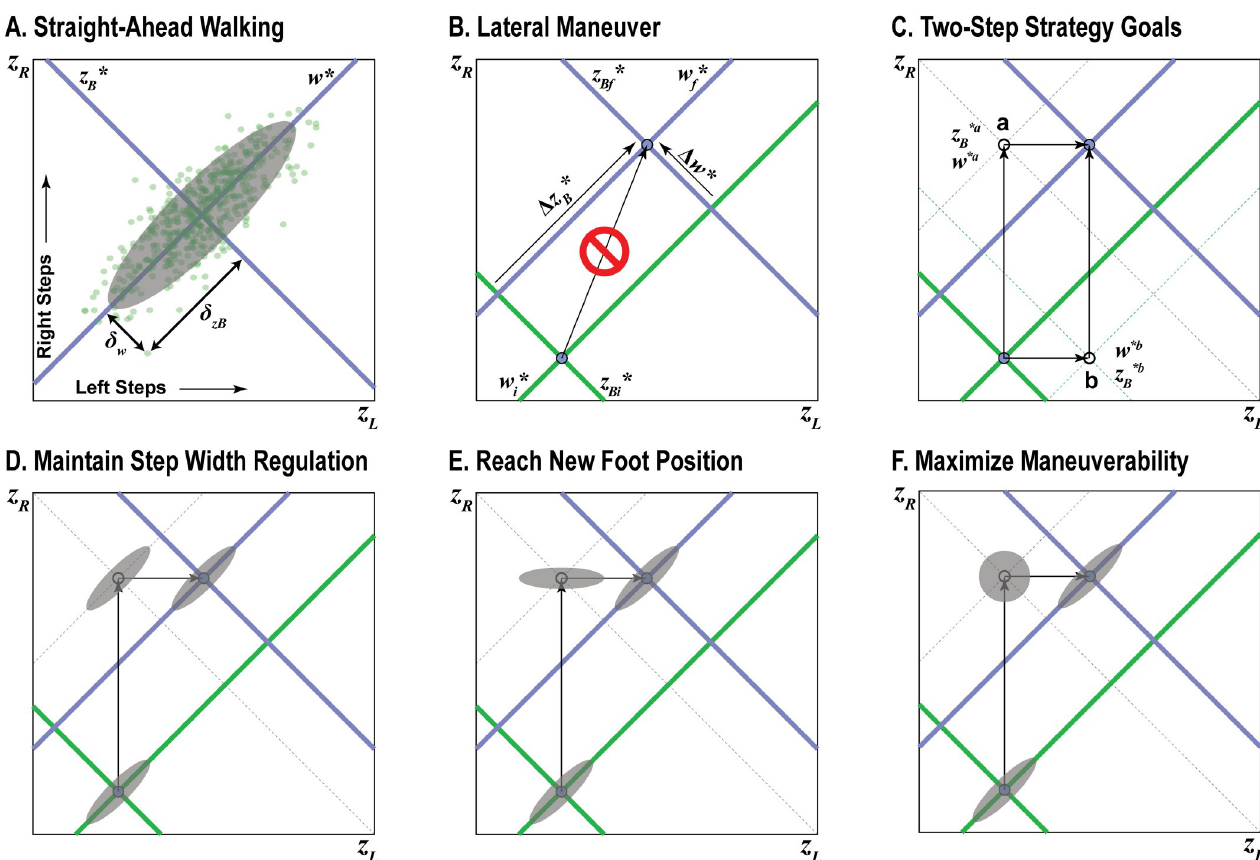
Fig 4. Conceptual Depiction of Task Performance. A) When viewed in the [ z L , z R ] plane, goals to maintain constant position ( z B � ) or step width ( w � ) each form linear Goal Equivalent Manifolds (GEMs) that are diagonal to the z � and w � GEMs characterize the stepping distribution at a given step and reflect the relative weighting of z both the z B walking, humans strongly prioritize regulating w over z B , producing stepping distributions strongly aligned to the w � GEM. B) Any maneuver would then involve a substantial change from some initial (green) to some new final (blue) stepping goals that will displace these GEMs diagonally in the [ z such as the theoretical rightward shift in z B � ( Δ z B � ) and increase in w � ( Δ w � ) depicted here. To accomplish such a maneuver requires changing both z L and z R . This cannot be achieved in any single step. C) At least two consecutive steps (either ‘a’: z maneuver ( Δ z B � and/or Δ w � ). Each possible intermediate step (‘a’ or ‘b’) has its own distinct stepping goals. D-F) For any given intermediate step, numerous feasible strategies to execute the maneuver are theoretically possible. D) One such strategy might be to maintain strong prioritization of w over z